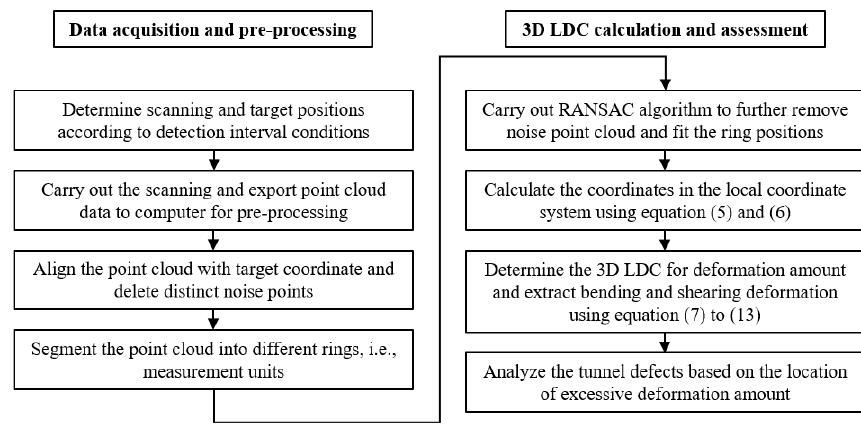
Figure 5. Workflow of proposed method.